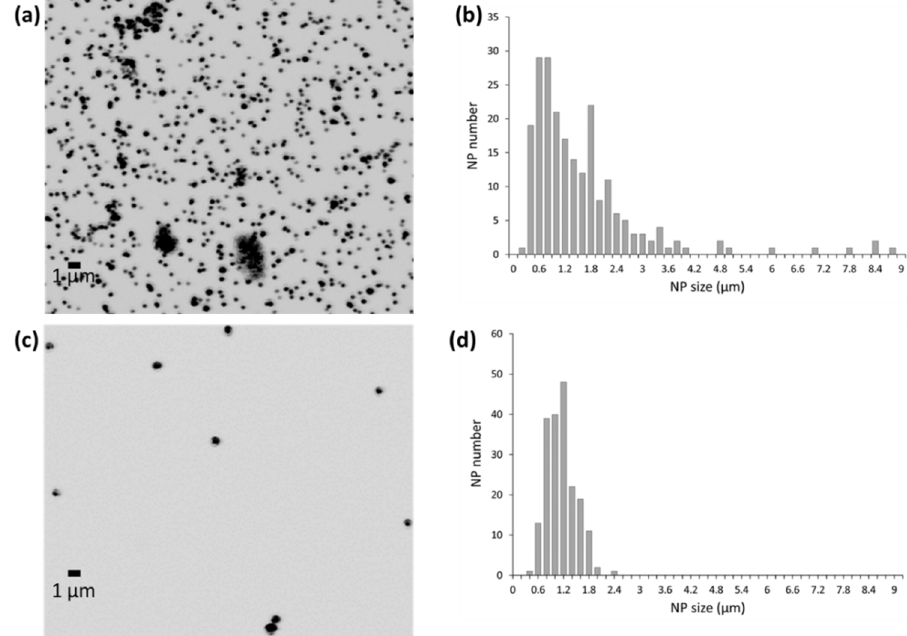
Figure 4. Confocal microscopy images for amplified ( a ) AuNPs and ( c ) Mn ‐ ZnS QDs after performing the complete PSA immunoassay and the catalytic gold deposition. The corresponding size distribution obtained for the amplified nanostructures is also shown for ( b ) AuNPs and ( d ) Mn ‐ ZnS QDs ( n = 250 particles).